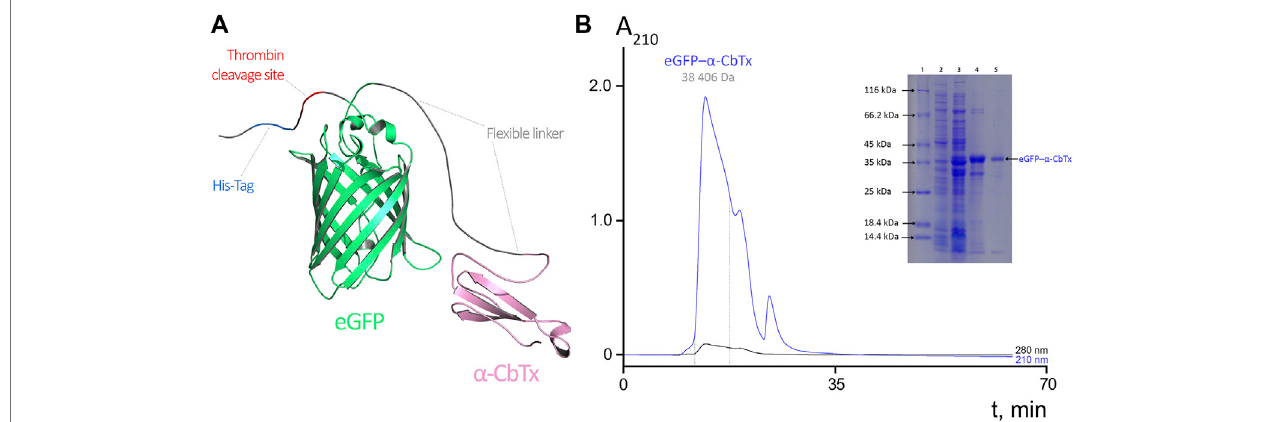
FIGURE 1 | (A) Molecular model of eGFP – α -CbTx chimeric protein. eGFP and α -CbTx modules are connected by a short fl exible linker. The His-Tag and adjacent thrombincleavagesitearelocatedattheN-terminusofthechimera. (B) Size-exclusionchromatographyofeGFP – α -CbTx.Thedottedlinesmarktheareacorresponding to the collected fraction that contained the chimeric protein. Detection was performed at 210 and 280 nm. The inset shows electrophoretic separation of fractions obtainedduringthepuri fi cationofeGFP – α -CbTxin12%polyacrylamidegel.1,standards(PierceUnstainedProteinMWMarker,#26610,ThermoFisherScienti fi c) for protein electrophoresis; 2, soluble fraction of total cellular protein before induction of expression; 3, after induction by IPTG; 4, chimeric protein after metal-chelate af fi nity chromatography; 5, chimeric protein after size-exclusion chromatography.